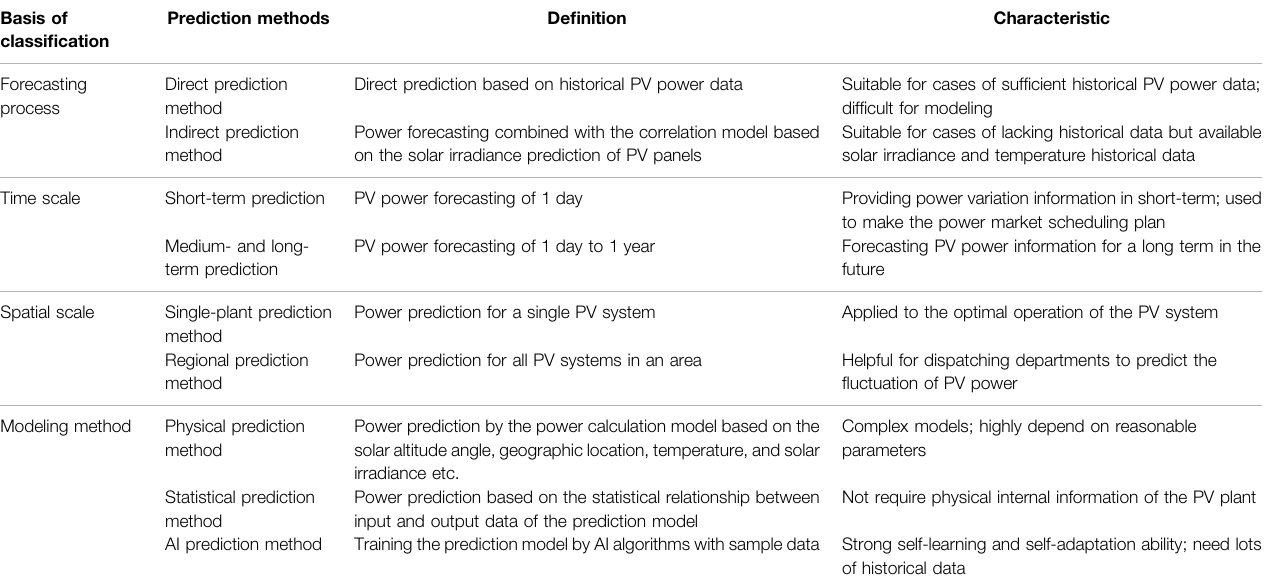
TABLE 1 | Classi fi cation of PV power prediction